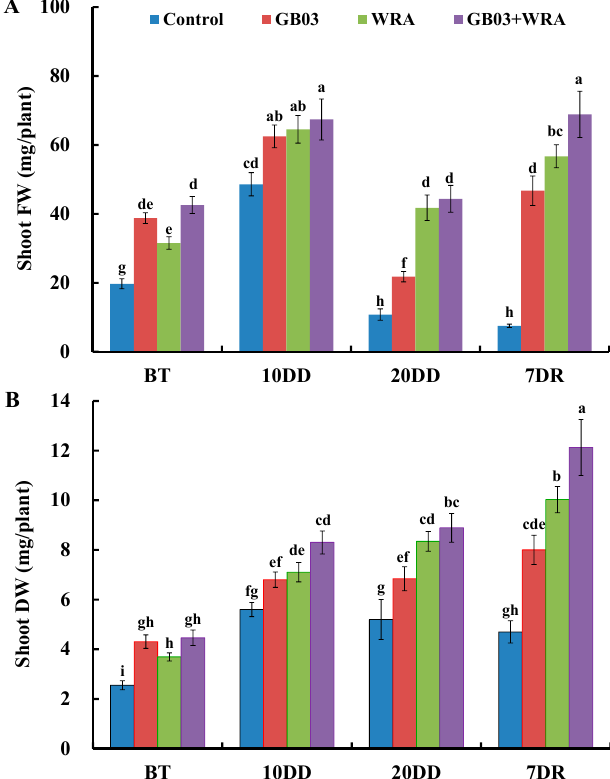
Figure 3. Effects of GB03, water retaining agent (WRA), or the combination of GB03+WRA on shoot fresh weight (FW) ( A ) and dry weight (DW) ( B ) of ryegrass. BT, before treatment (20-day-old seedling); 10DD, 10-day natural drought; 20DD, 20-day natural drought; 7DR, 7 days after rewatering. Values are means and bars indicate SEs ( n = 12). Columns with different letters indicate significant differences among treatments at p < 0.05 (ANOVA and Duncan’s post-hoc multiple comparison test). Three treatments (GB03, WRA and GB03+WRA) significantly increased shoot dry weight by 68.7%, 44.5% and 74.7% compared to control, respectively, after growing for 20 days (Figure 3B). After 10-day drought, WRA and GB03+WRA treatments increased shoot dry weight significantly by 26.8% and 48.2%, respectively, compared to control. After 10-day drought, three treatments (GB03, WRA and GB03+WRA) were significantly 31.5%, 60.5% and 70.9% higher in dry weight than control,